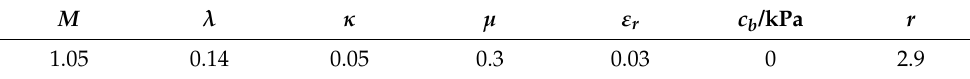
Table 4. Material parameters for Kaolin clay.